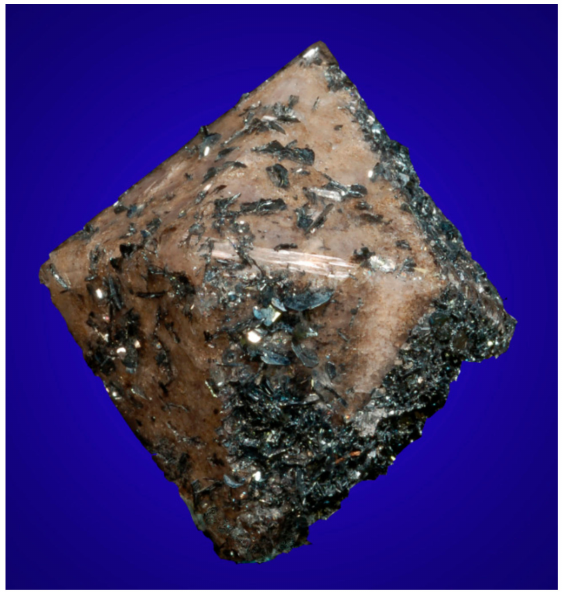
Figure 15. Quartz and hematite, Chub Lake prospect. 2.7 cm. Chamberlain Collection, NYSM C5935.